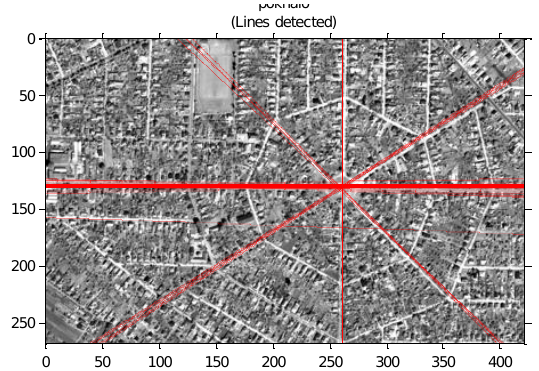
Figure 7. Extracted lines projected onto the 3 m resolution